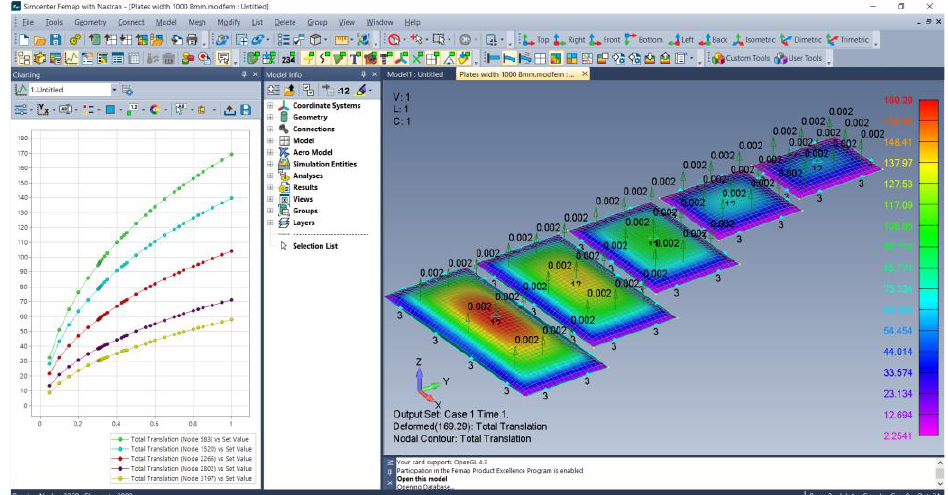
Figure A1. Femap typical screen.